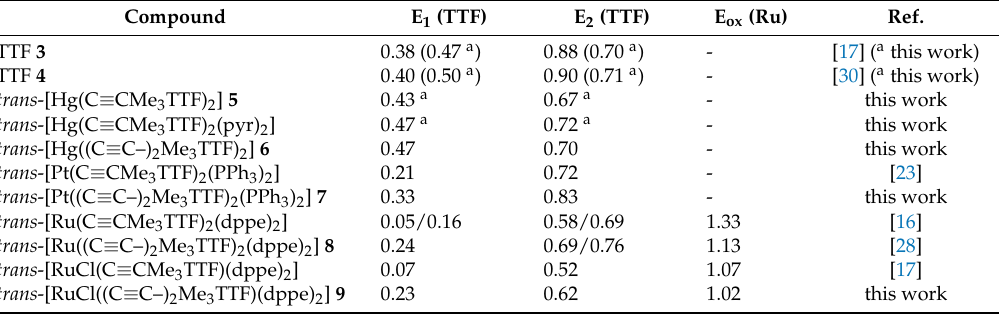
Table 3. Redox potentials of the various complexes issued from TTFs 3 and 4 in CH 2 Cl 2 , E vs. SCE.